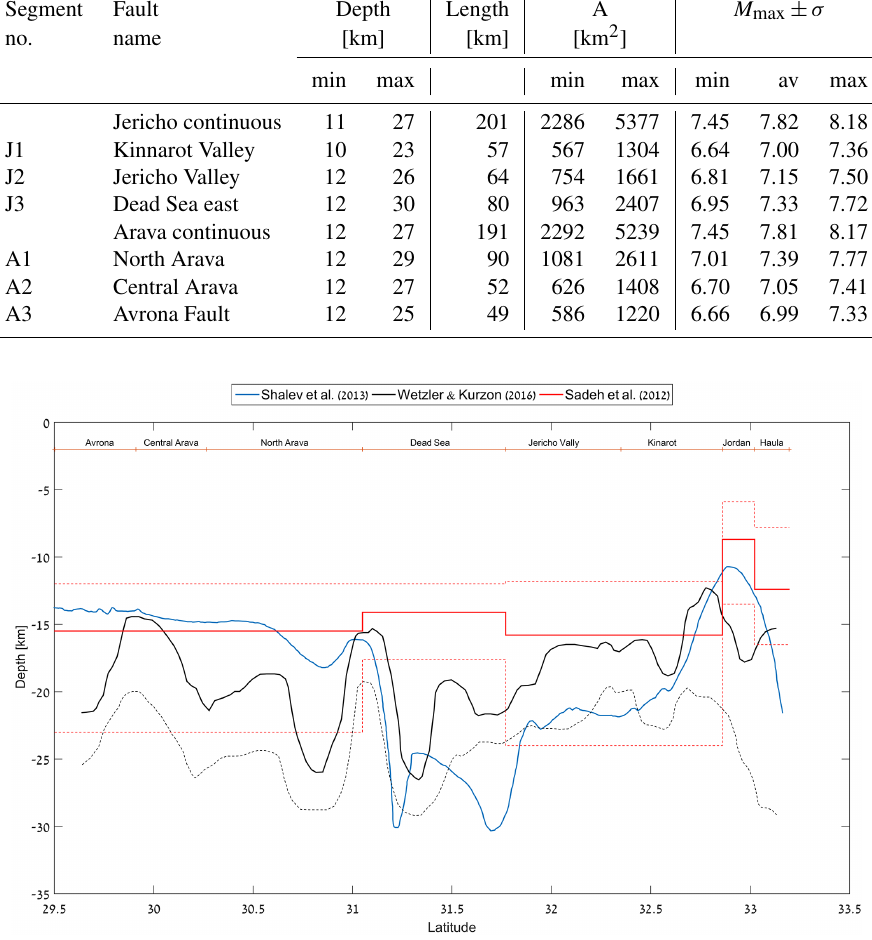
Figure 7. The range of evaluations for the seismogenic crustal depth along the DST, based on three independent studies. The x axis represents a cross section along the DST – from south (left) to north (right). The figure is drawn at a vertical exaggeration of 11. In the Wetzler and Kurzon (2016) study, the solid line represents the 75th percentile, while the dashed line represents the 95th percentile. In the Sadeh et al. (2012) study, the solid line represents the estimated depth with a confidence level of 68%, while the dashed lines represent 2 standard deviations above and below that estimate. The Shalev et al. (2013) study is represented by one solid line, which is based on their 350 ◦ C